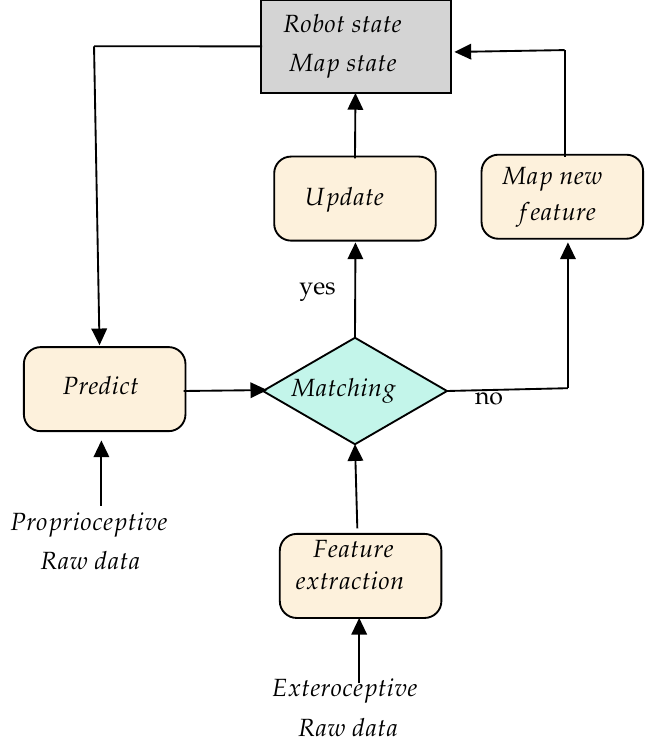
Figure 1. Block diagram of the EKF-SLAM process. When exteroceptive data are coming at time t , the state of the robot is predicted at this time with Equation (5), and the detected features are matched with those in the map. The matches allow updating the state and map using Equation (6). If the detection is not in the map, it is initialized when possible and added to the map. This process is done recursively (see Equation